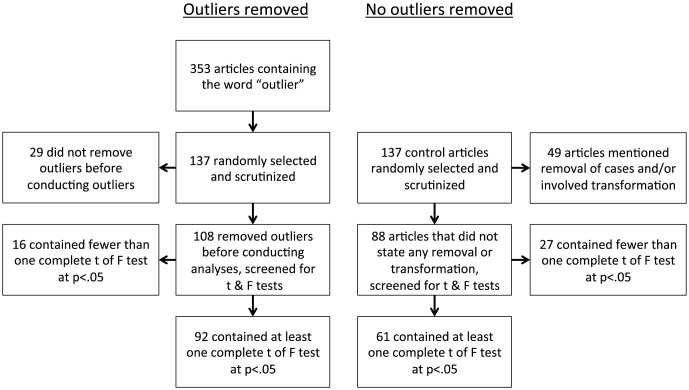
Flowchart of papers in the set of papers that stated outlier removal (left) and the set of papers that did not report any removal of outliers (right).